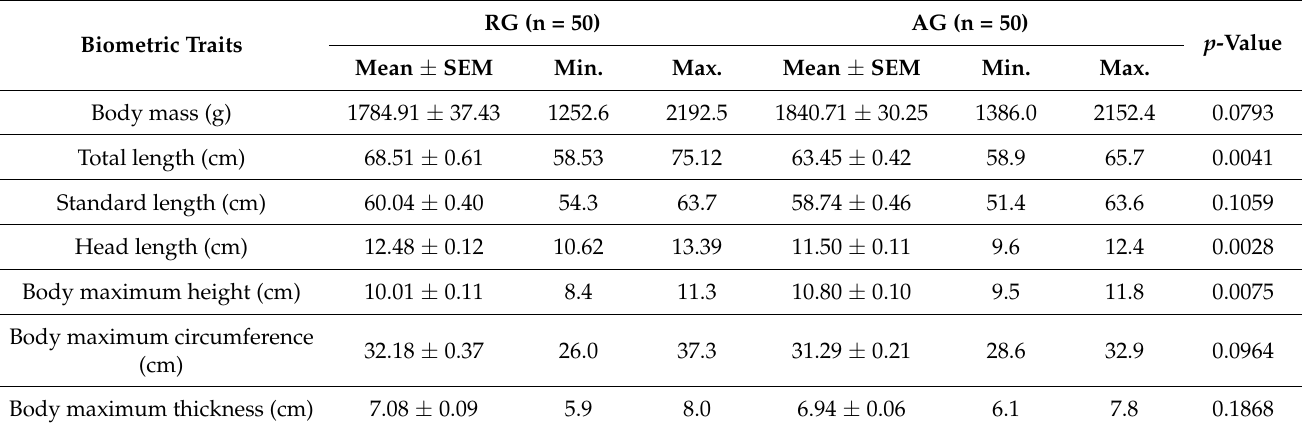
Table 1. Main biometric assessments in European catfish ( Silurus glanis ).